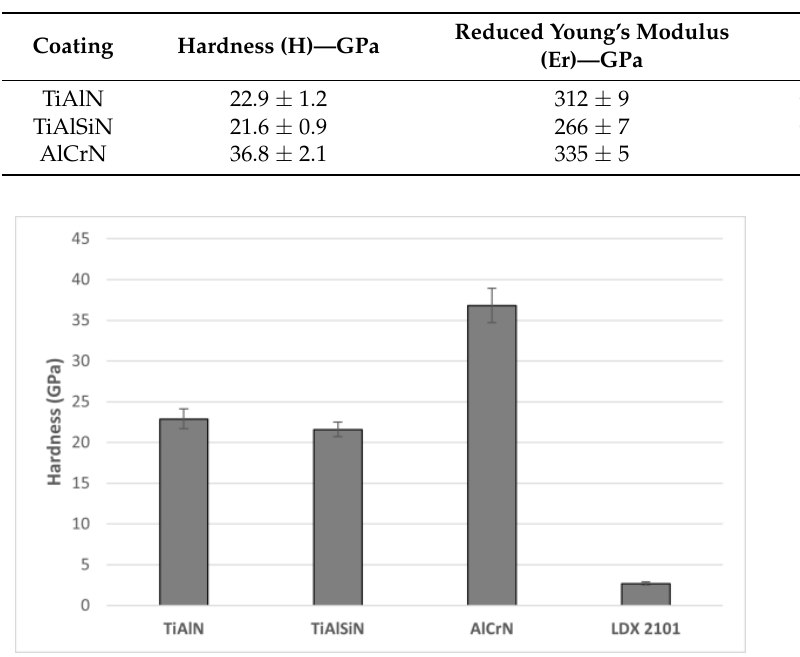
Figure 3. Hardness values of the tested coatings and base material (UNS S32101).